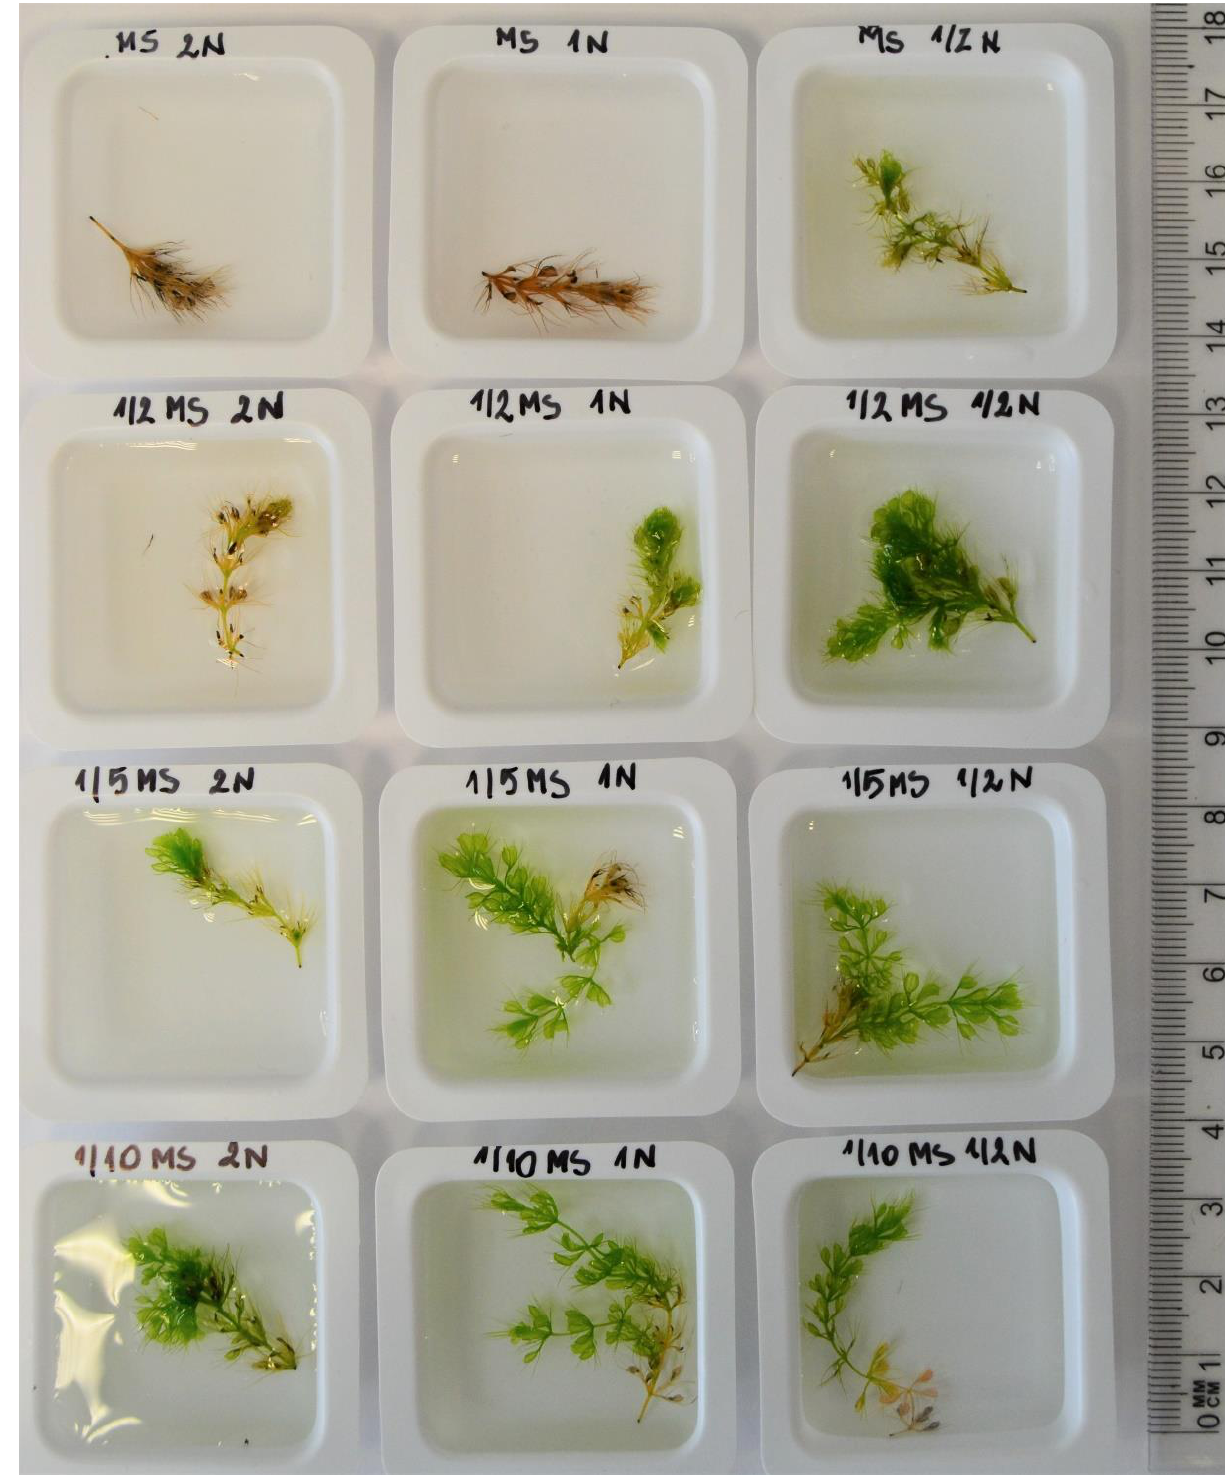
Figure 8. Shoots of Aldrovanda vesiculosa depending on the concentration of the media and nitrogen after 6 weeks in tissue culture. MS, 1/2MS, 1/5MS, 1/10MS represent the Murashige and Skoog medium concentration, 2N, 1N, and 1/2N represent the NH 4 NO 3 + KNO 3 concentration of the MS formulation.